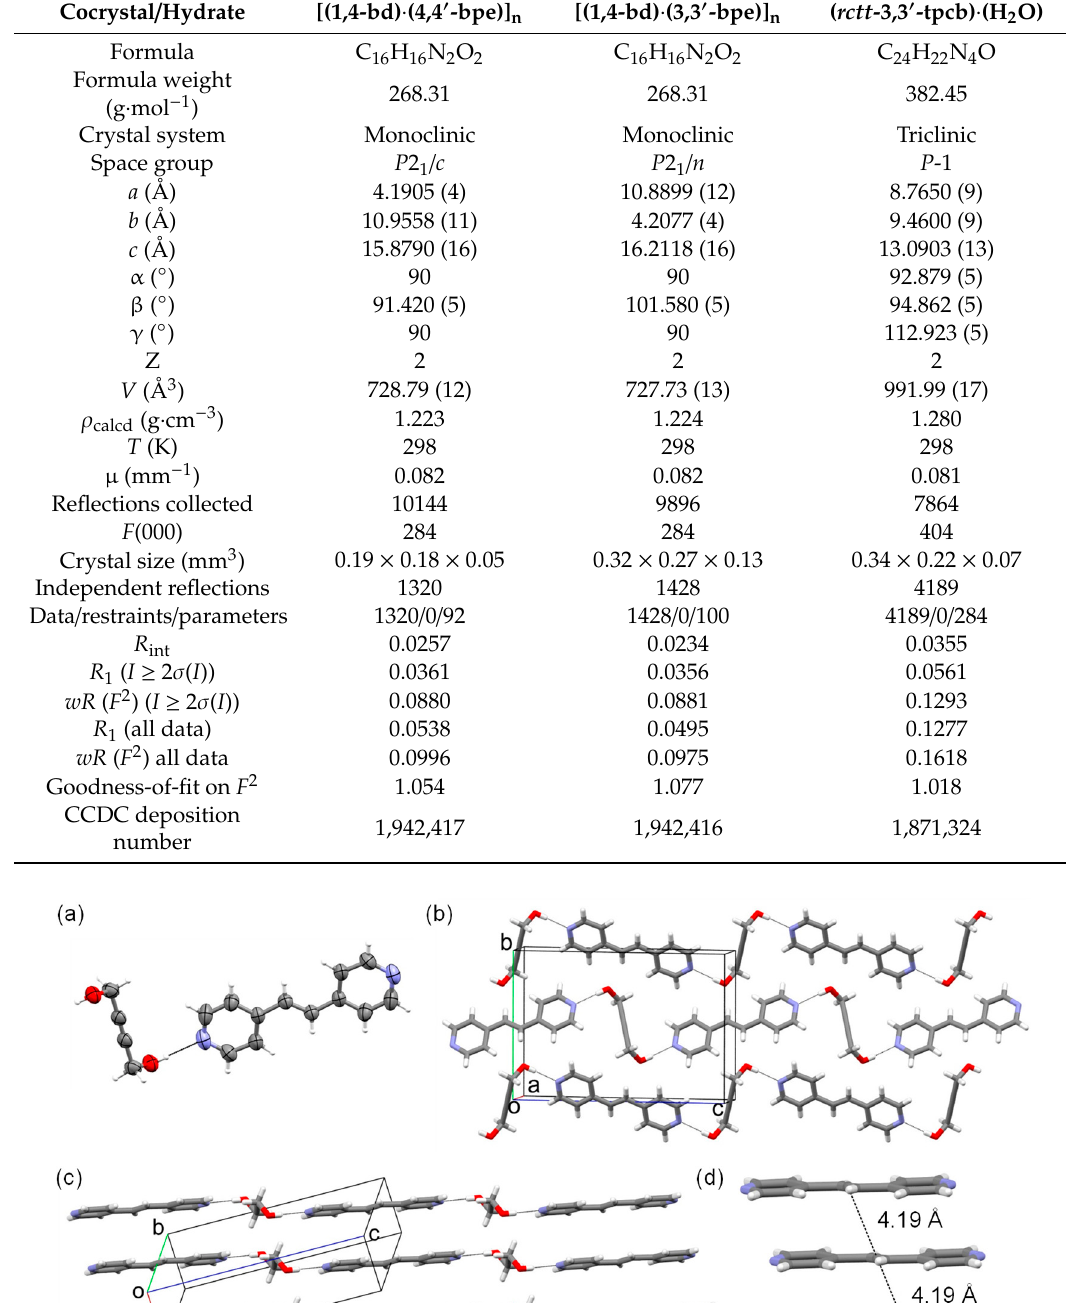
Table 1. Crystallographic data for [( 1,4-bd )·( 4,4’-bpe )] n , [( 1,4-bd )·( 3,3’-bpe )] n , and ( rctt - 3,3’- tpcb )·(H 2 O).